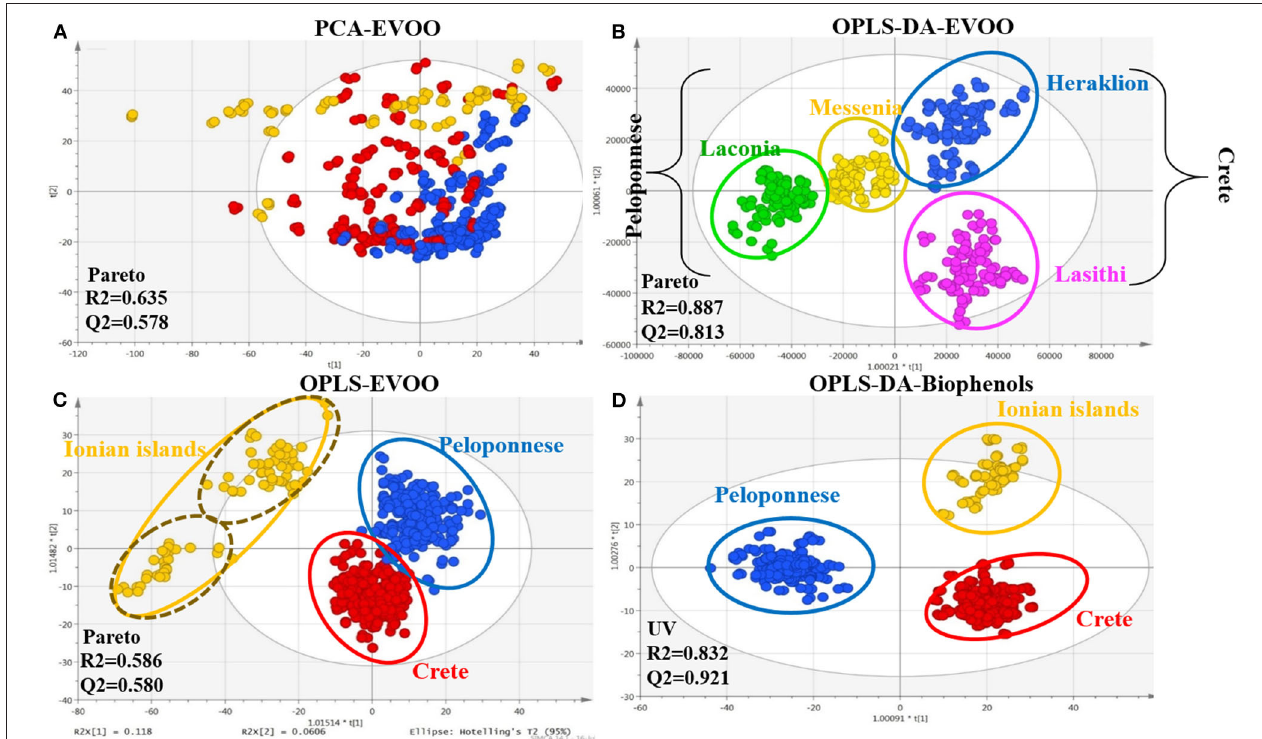
FIGURE 2 | Scores plots of EVOOs and their corresponding biophenol extract acquired via FIA-MRMS. Observations are colored coded according to geographical origin. (A) PCA scores plot of EVOOs including all observations (pareto scaling); (B) OPLS scores plot of EVOOs including all observations (pareto scaling); (C) OPLS-DA plot of EVOOs excluding Ionian island samples (pareto scaling); and (D) OPLS-DA scores plot of biophenol extracts including all observations (UV scaling). R2/Q2 model parameters are annotated (bottom-left).